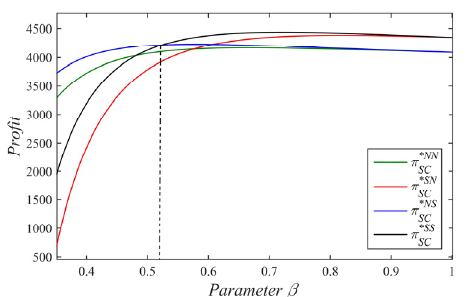
Figure 6. The impact of parameter